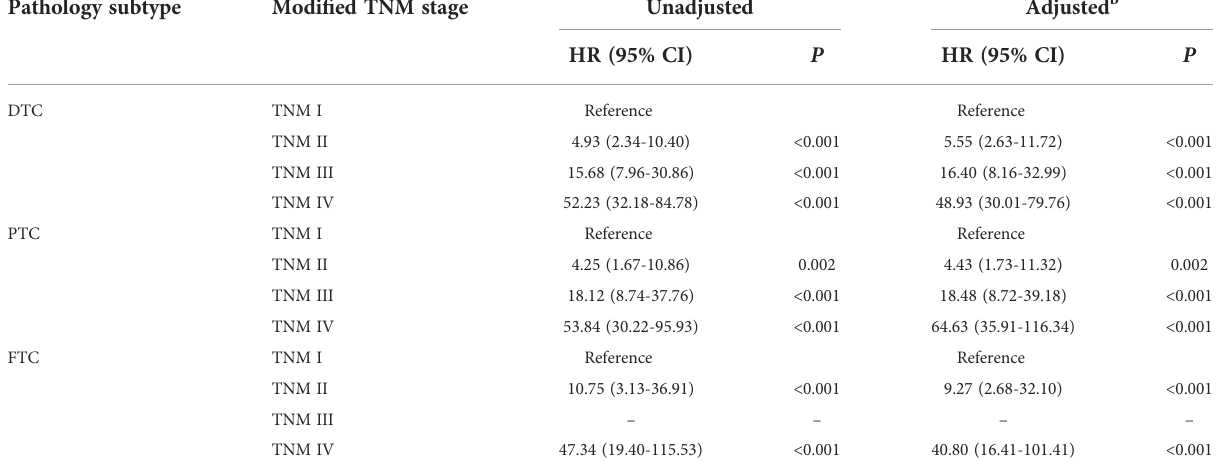
TABLE 4 Hazard ratios of the modi fi ed TNM staging system for cancer-speci fi c survival. Pathology